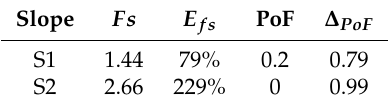
Table 6. Summary of results after the realization of engineering naturalistic